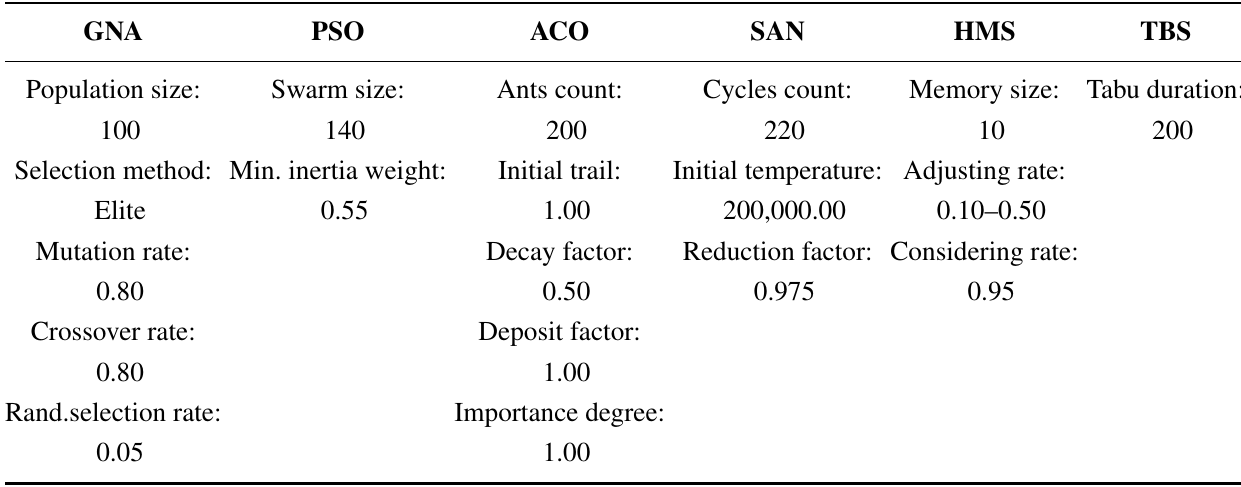
Table 5. Input parameters used for metaheuristic methods comparison. GNA, genetic algorithm; PSO, article swarm optimization; ACO, ant colony optimization; SAN, simulated